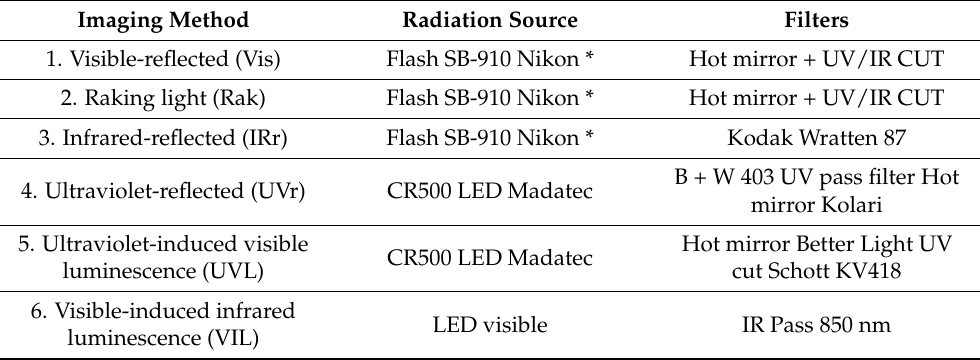
Table 1. Description of the radiation source and filters for the different imaging methods and in parenthesis the abbreviation used in the text to indicate the type of